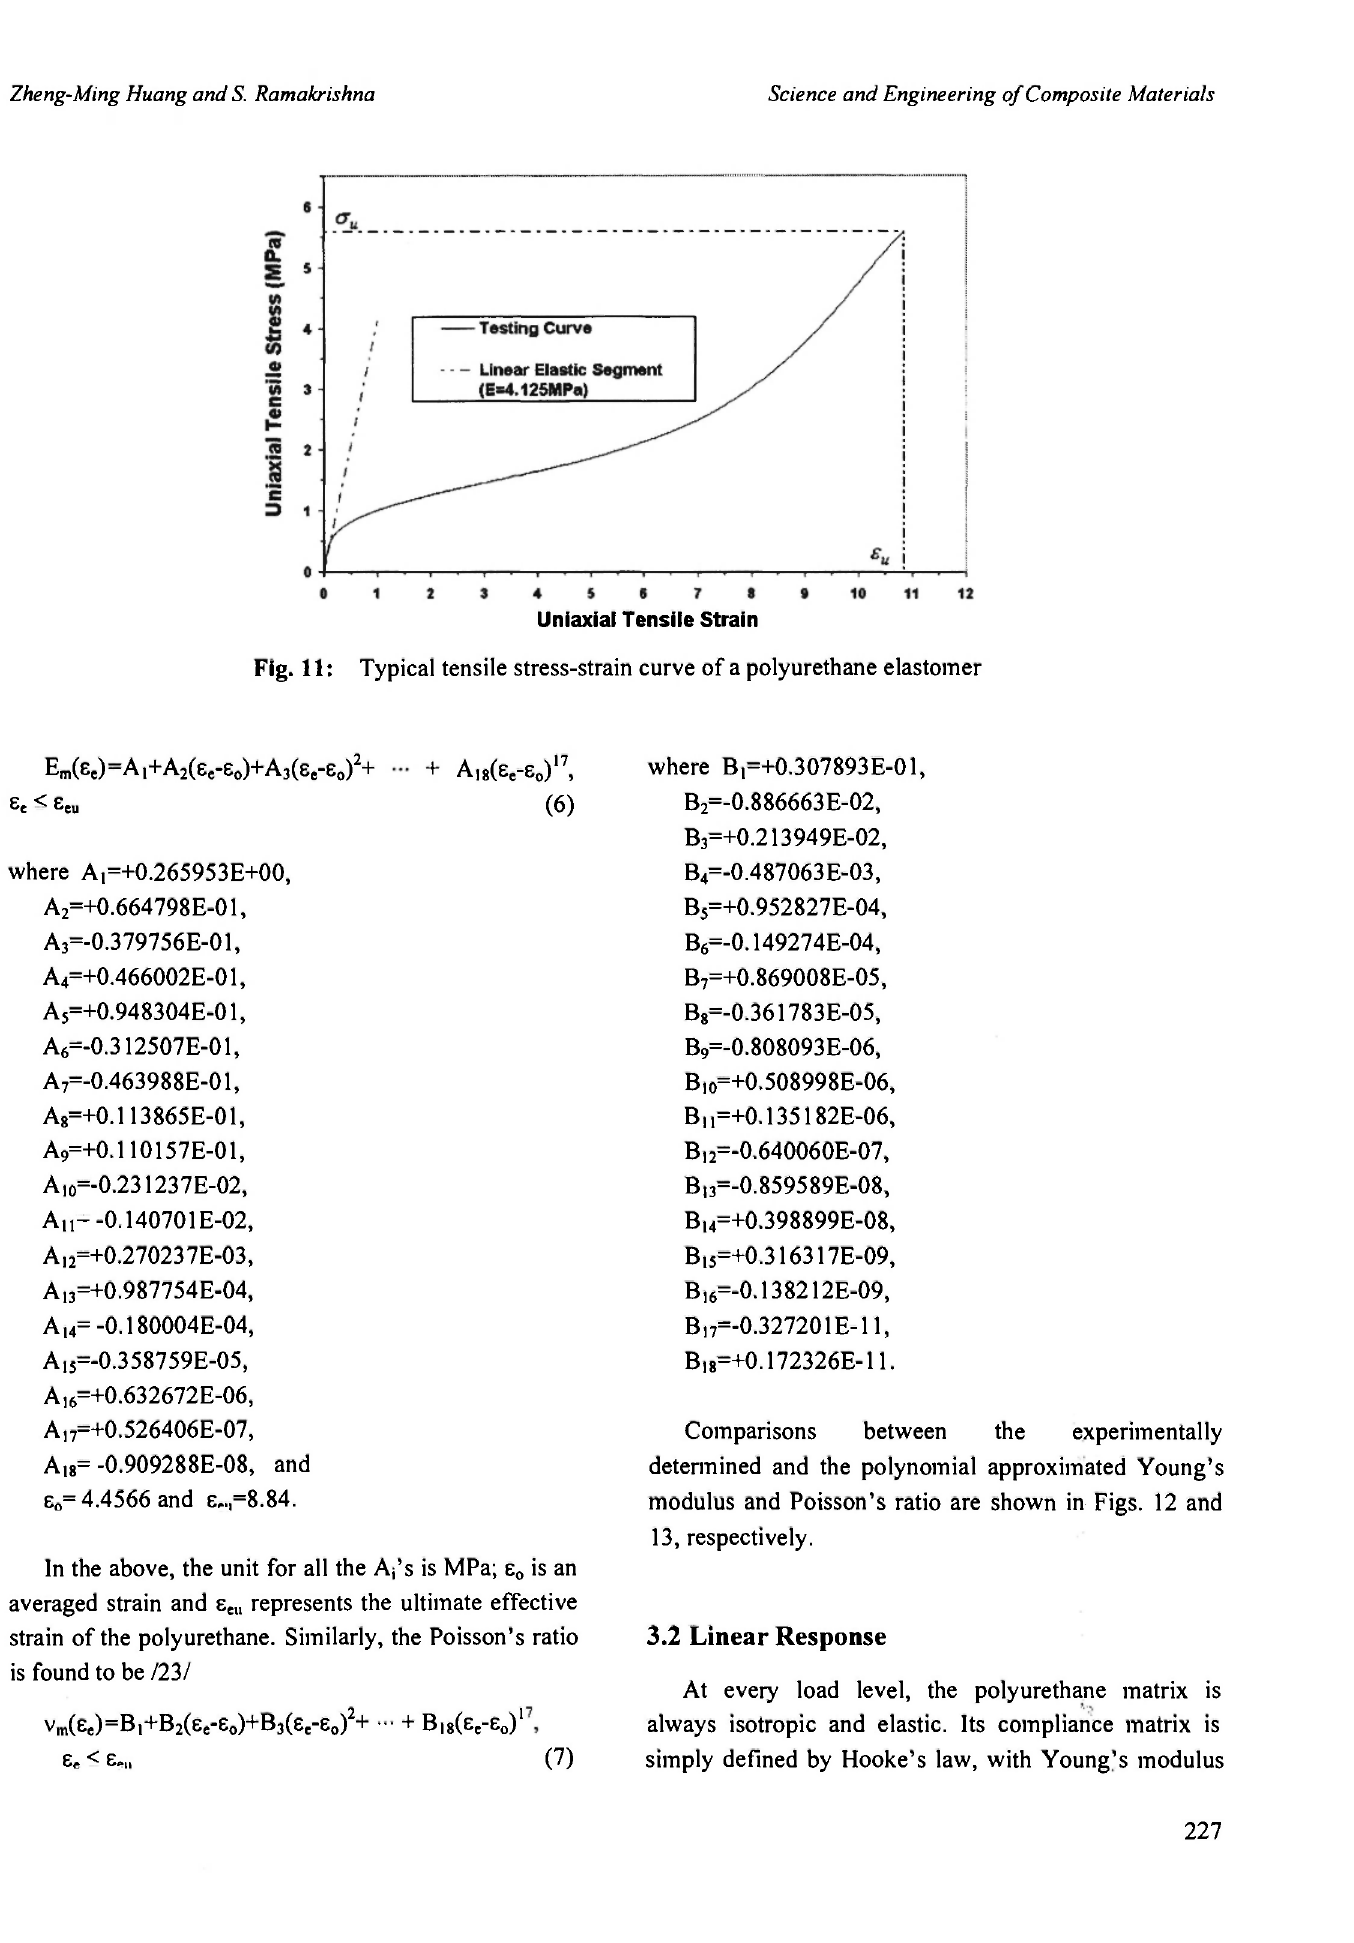
Fig. 11: Typical tensile stress-strain curve of a polyurethane elastomer